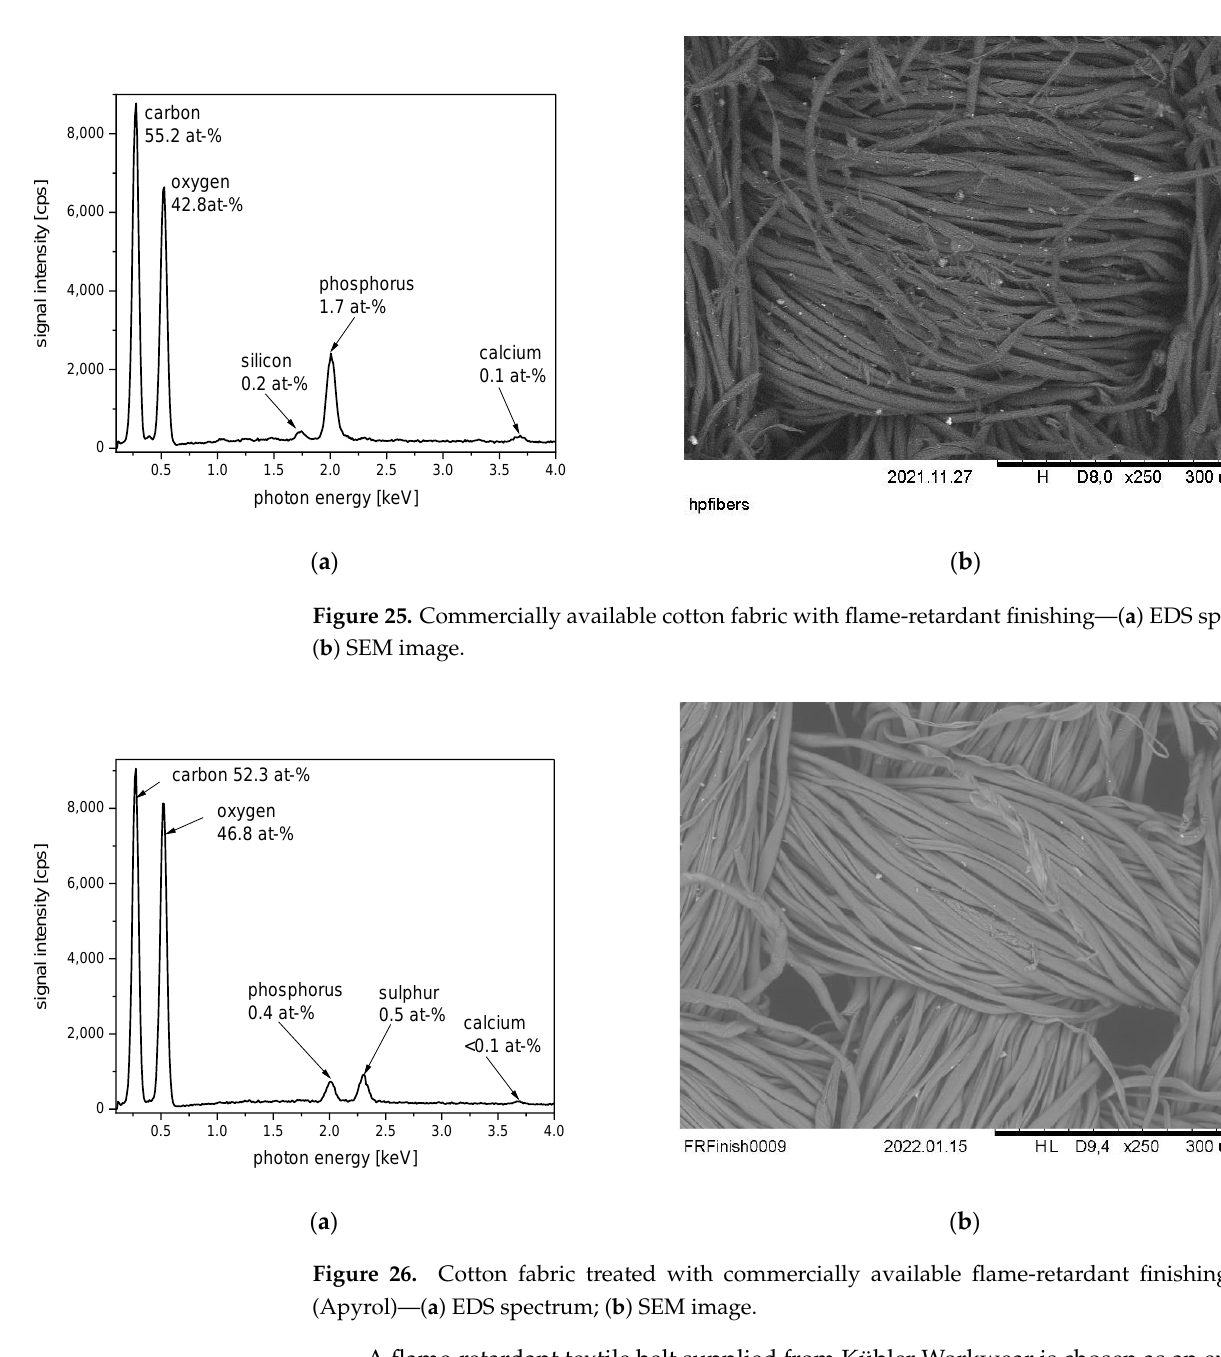
Figure 26. Cotton fabric treated with commercially available flame-retardant finishing agent (Apy- rol) — ( a ) EDS spectrum; ( b ) SEM image.